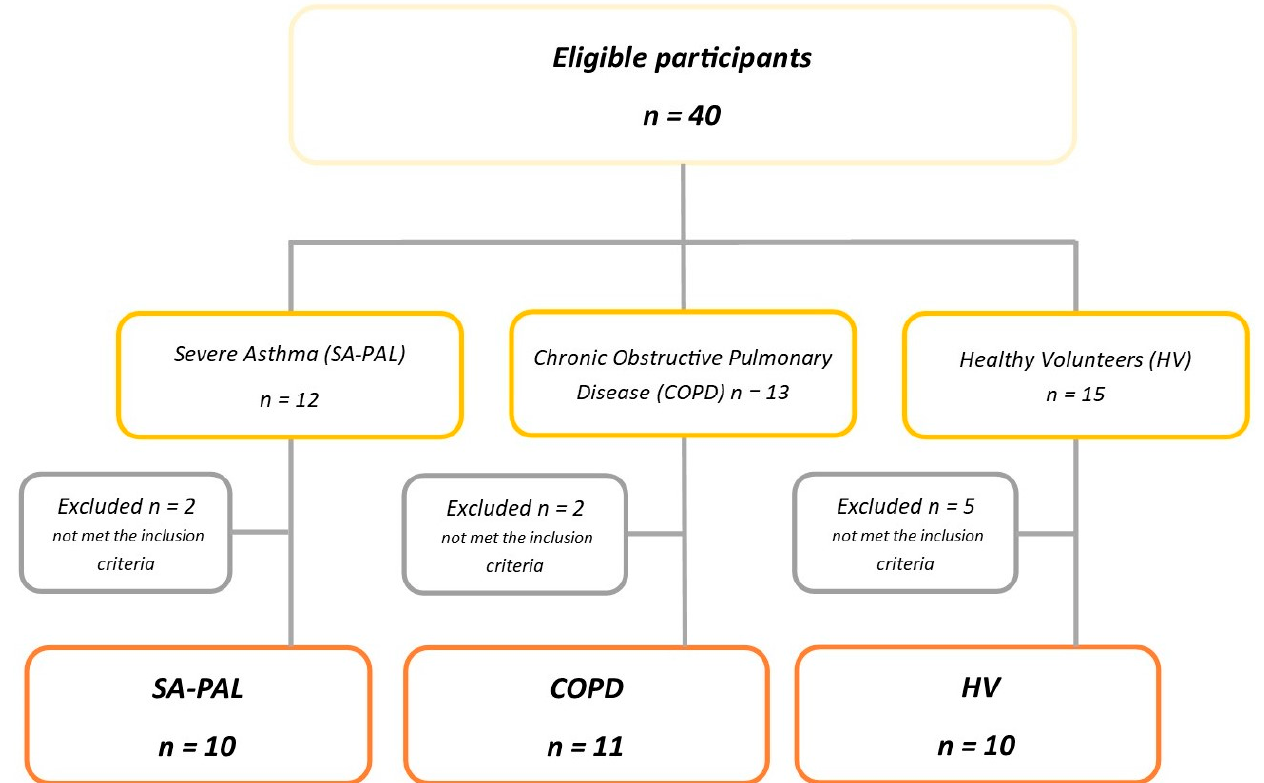
Figure 1. Patients’ flowchart.